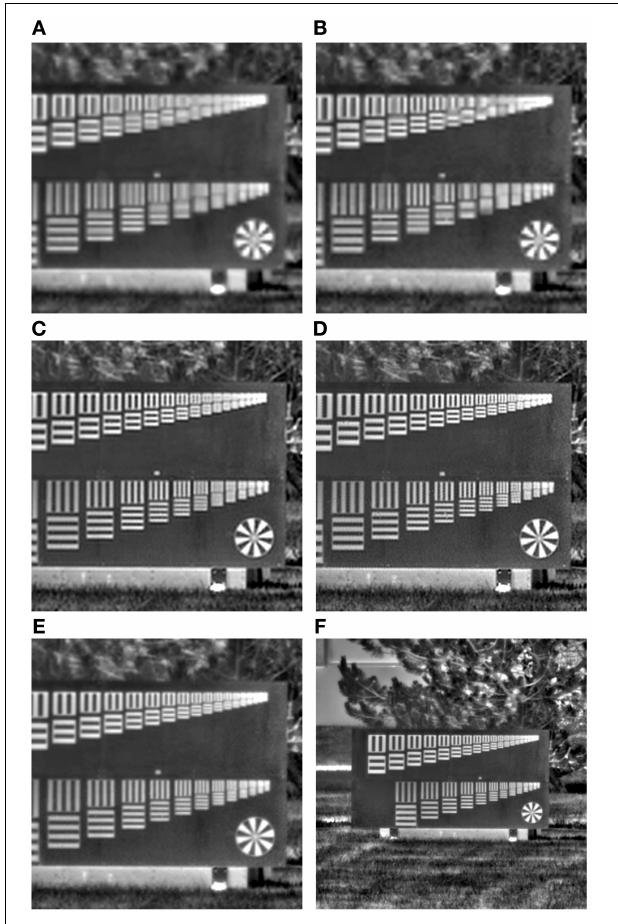
FIGURE 28 | ROI from real MWIR sensor data of bleachers at Great American Ball Park in Cincinnati. (A) L = 3 bicubic interpolation of simulated 100% fill factor detector image at p = 30 μ m; (B) bicubic interpolation of simulated 25% fill factor detector image at p = 30 μ m; (C) K = 16 and L = 3 AWF SR using 100% fill factor detectors; (D) K = 16 and L = 3 AWF SR using 25% fill factor detectors; (E) native sensor image with p = 15 μ m; (F) larger native sensor